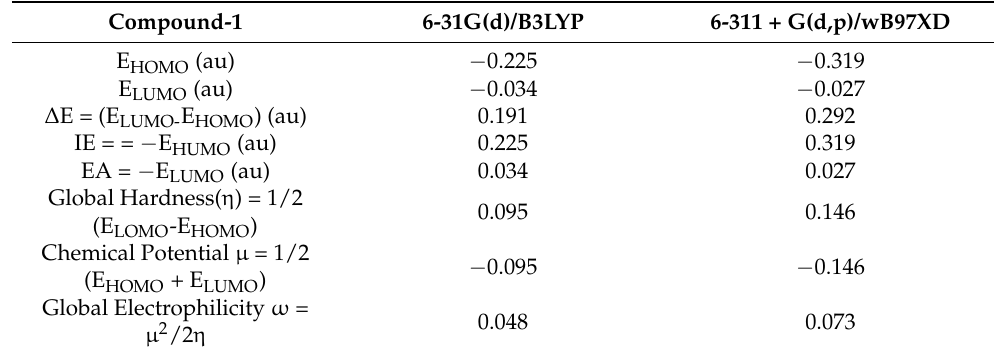
Table 3. Calculated chemical parameters of Compound 1 computed at various level of DFT and basis sets, with values shown in atomic unit